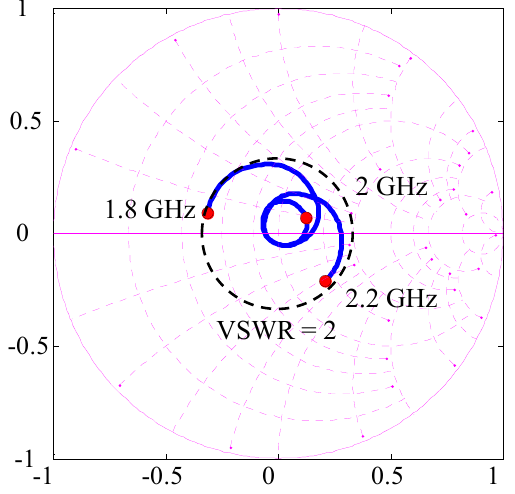
Figure 19. Measured impedance of Subarray2.